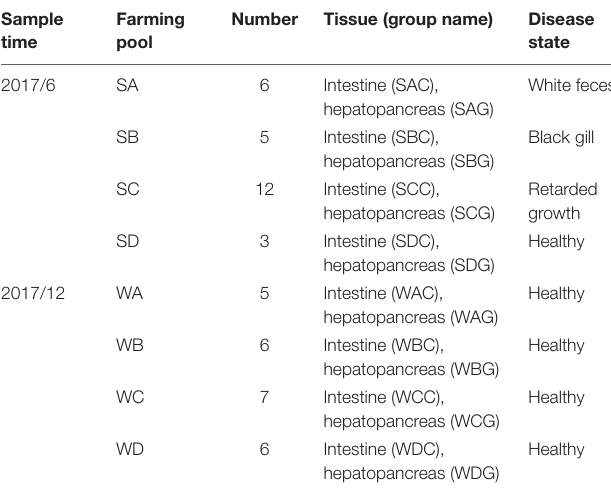
TABLE 1 | Shrimp samples used to detect hepatopancreas and intestinal